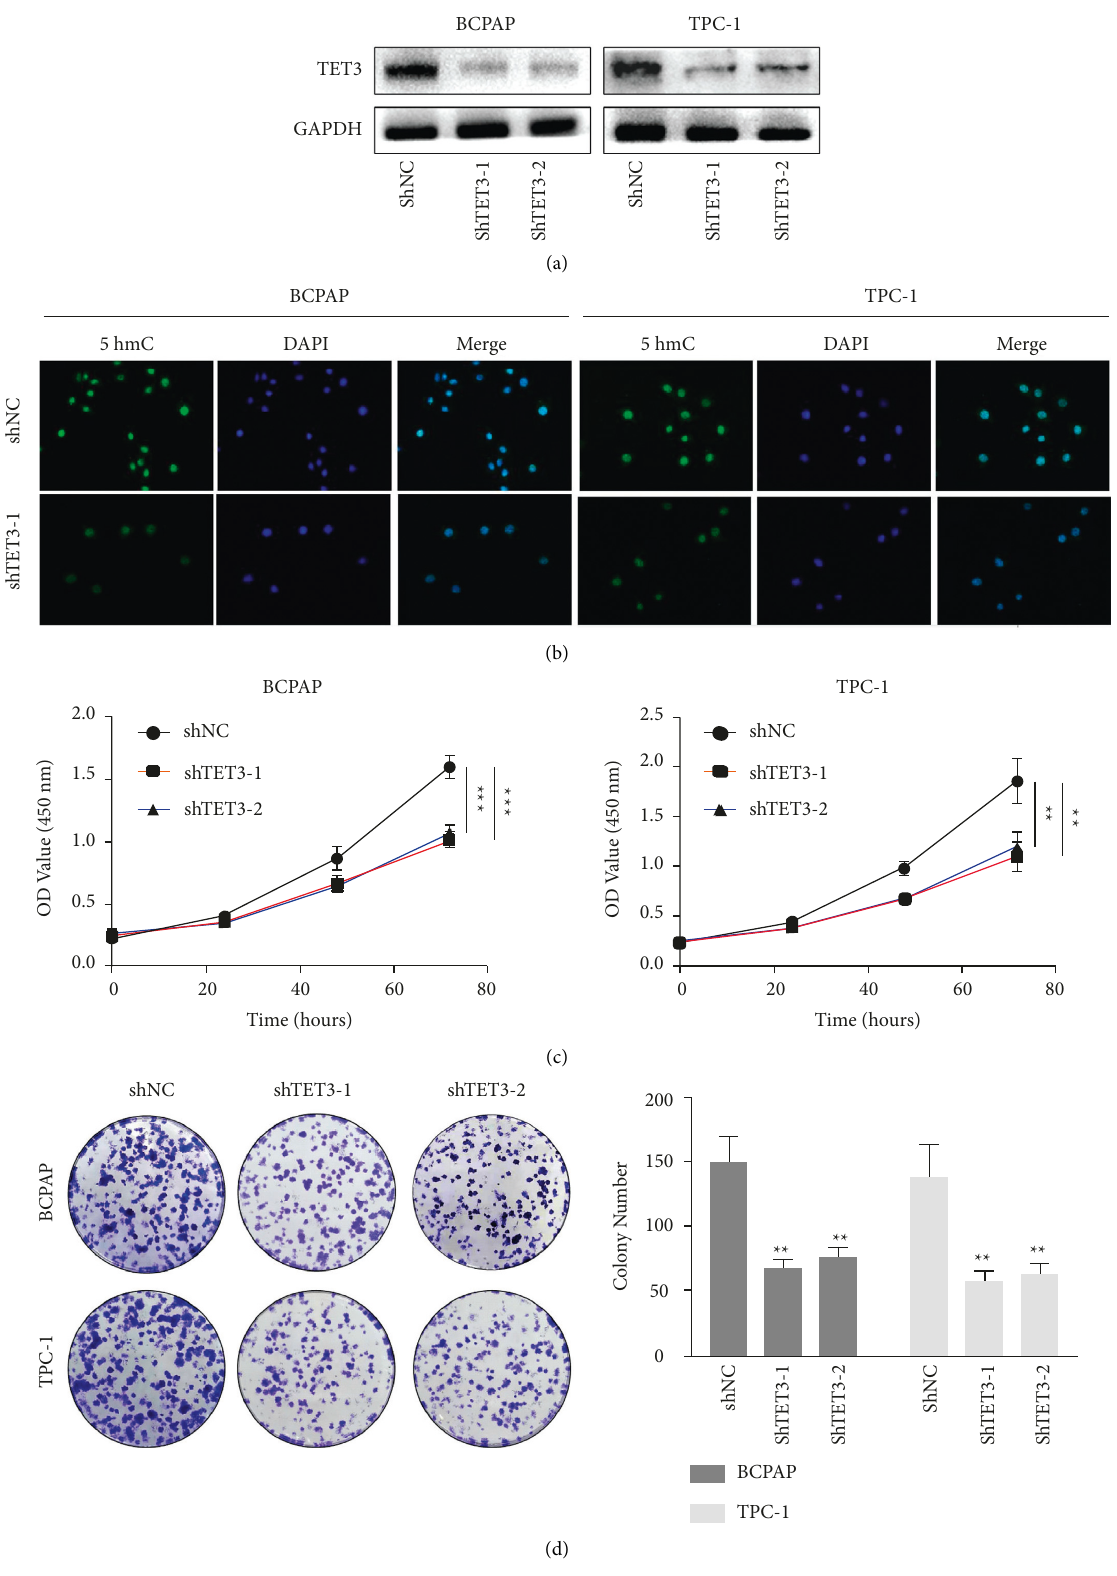
Figure 2: (a) Western blot verified the expression level of TET3 was decreased with shTET3 intervention in BCPAP and TPC-1 cells; (b) the results of immunofluorescence showed that inhibiting the expression of TET3 significantly decreased the 5hmC level of papillary thyroid carcinoma cell lines BCPAP and TPC-1. Upper panel: 5hmC staining (green); lower panel: DAPI staining (blue), superimposed with 5hmC staining; (c) CCK-8 assays and (d) colony formation assays showed that TET3 knockdown significantly suppressed cell proliferation in BCPAP and TPC-1